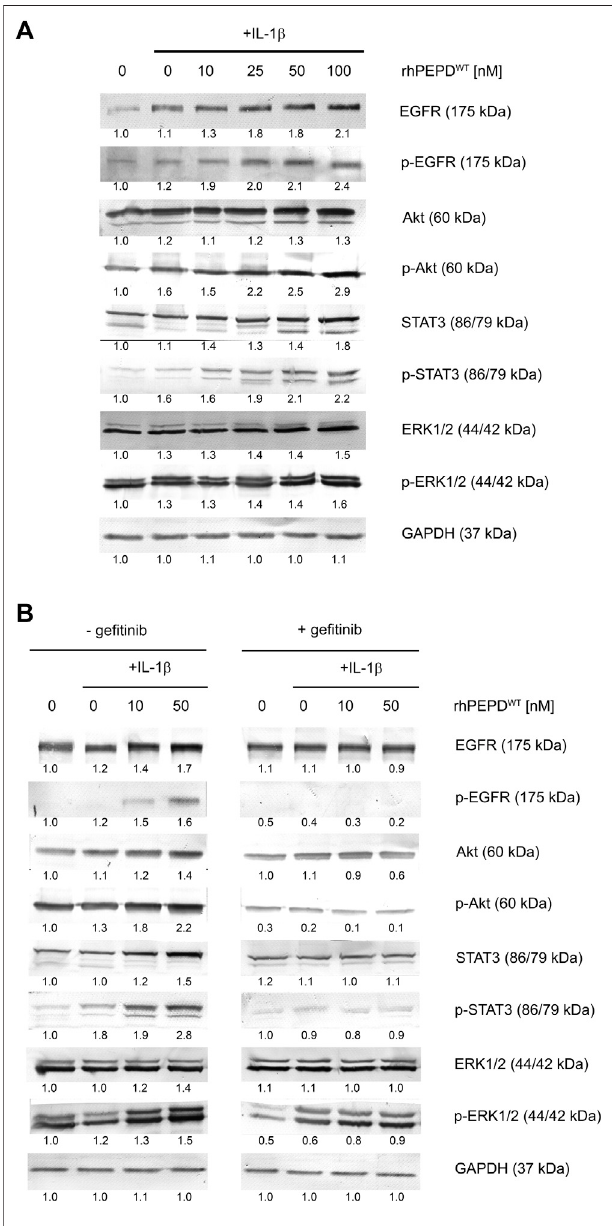
FIGURE 2 | rhPEPD WT augments IL-1 β -induced EGFR-downstream signaling pathway in HaCaT cell: (A) Western immunoblotting for the proteins of EGFR-downstream signaling pathway in lysates of rhPEPD-treated HaCaT cells (rhPEPD WT , 10, 25, 50, 100 nM) for 15 min and 24 h in presence or absence of IL-1 β (10 ng/ml). GAPDH was used as loading control; (B) Western immunoblotting for the proteins of EGFR-downstream signalingpathwayinlysatesofrhPEPD WT -treatedHaCaTcells(rhPEPD WT ,10, 50 nM) and pretreated with an inhibitor of EGFR (ge fi tinib, 2 µM for 2 h) cultured for 15 min and 24 h in presence or absence IL-1 β . GAPDH was used as a loading control. The data are presented as the mean ± SD, n = 3 in each group and compared to the control group. Representative blot images are shown (densitometry of protein stains is presented under protein bands as a ratio versus control; Supplementary Figure S1